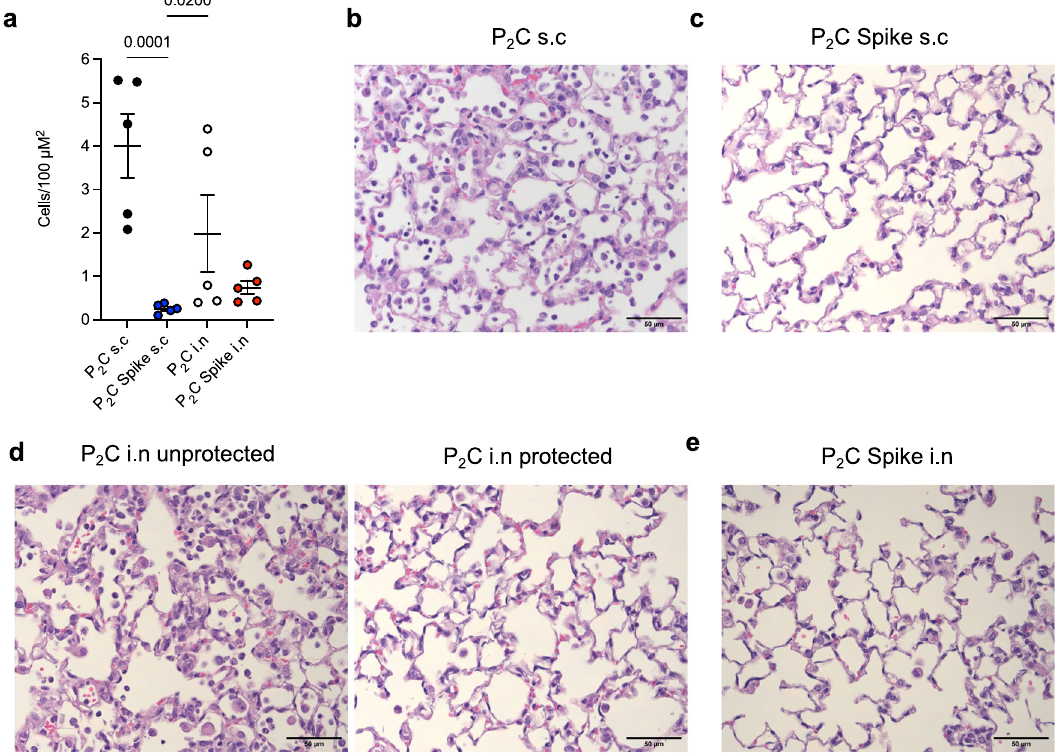
Fig. 9 | Pam 2 Cys Spike vaccination protects mice from damaging leukocyte in fi ltration of the lung parenchyma during SARS-CoV-2 infection. a Quantitation of in fl ammatory cells in the lung parenchyma of vaccinated mice 7daysp.i,Pam 2 Cysalone(P 2 C;black),orPam 2 CysSpike,sub-cutaneously(s.c;blue) or intra-nasally (i.n; red) Data are for individual mice ( n =5 each), means+/ − SEM are shown. Statistics: p values indicated, Kruskal – Wallis test, Dunn ’ s multiple